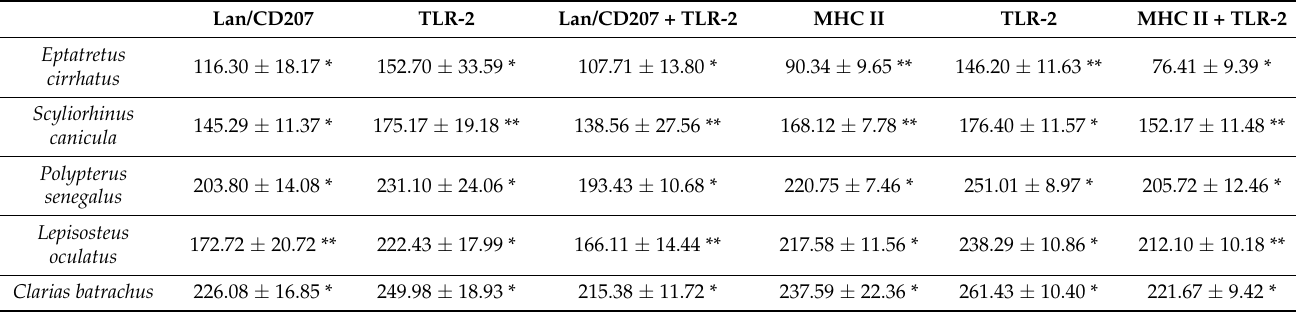
Table 2. Statistical analysis data (mean values with